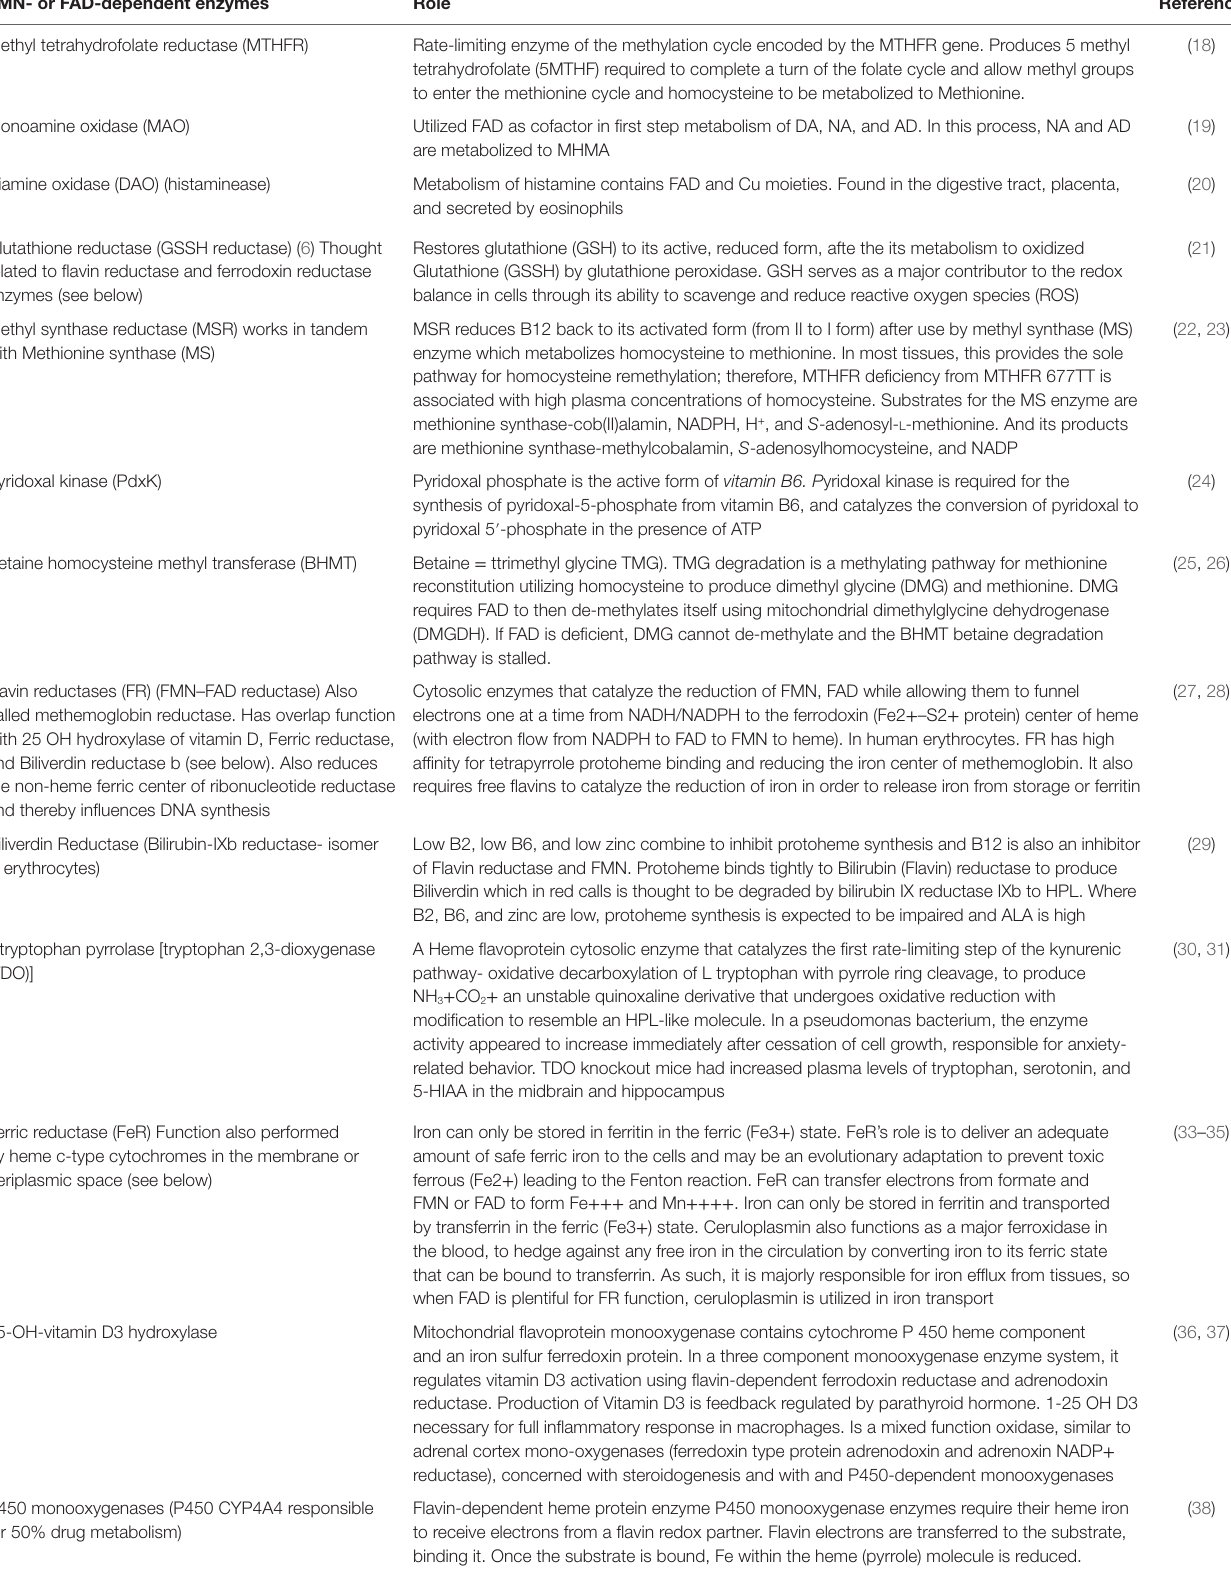
TaBle 6 | Key enzymes utilizing FMn or FaD in the biochemistry of schizophrenia or schizoaffective psychosis. FMn- or FaD-dependent enzymes role